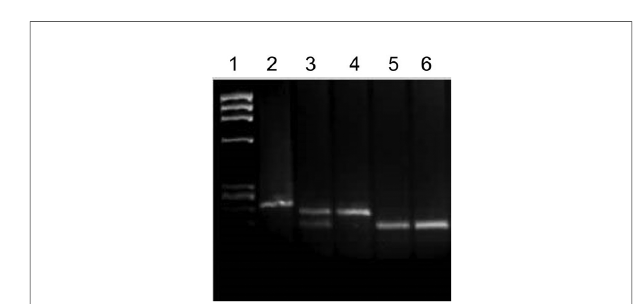
FIGURE 2 Detection of IL13 gene polymorphism p .(Arg130Glu; rs20541) genotypes. Lane 1, Hae II cleaved ϕ X174 DNA M r size markers; lane 2, un-cleaved PCR product (210 bp); lane 3, PCR products cleaved with restriction enzyme Nla IV from a subject with RQ genotype (210 and 178 bp); lanes 4, PCR products cleaved with restriction enzyme Nla IV from a subject with RR genotype (210 bp); lanes 5-6, PCR products cleaved with restriction enzyme Nla IV from subjects with